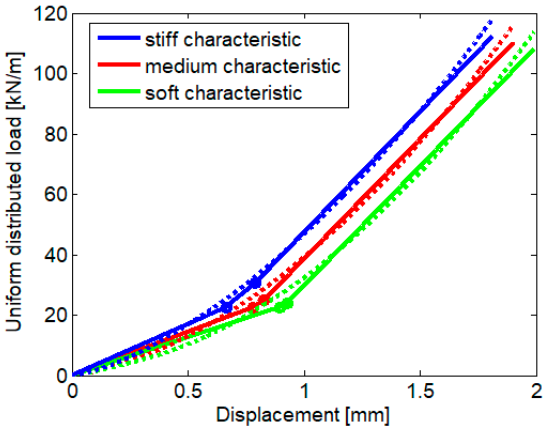
Figure 8. Equivalent characteristics.